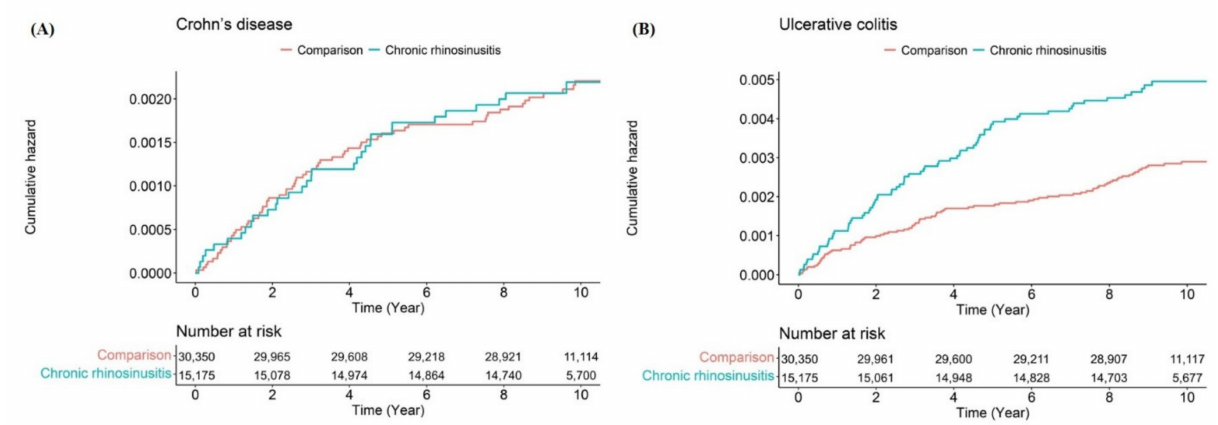
Figure 2. Cumulative hazard plot of ( A ) Crohn’s disease and ( B ) ulcerative colitis between the chronic rhinosinusitis and comparison groups.